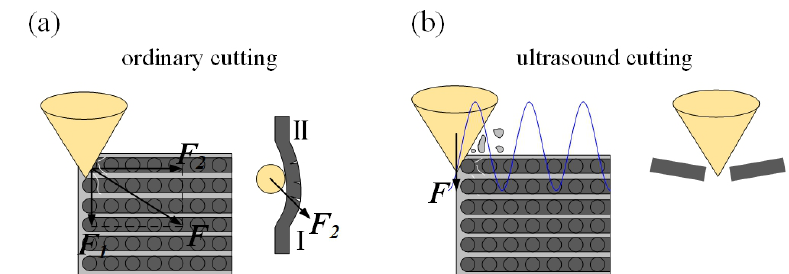
Figure 12. Typical morphologies after cutting C/SiC composites at 45 ◦ . ( a ) is ordinary cutting and ( b ) is ultrasound-assisted grinding.